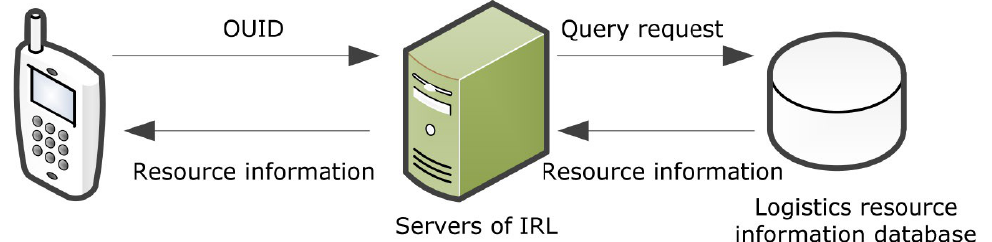
Figure 7. Process of Two Dimensional Bar-code Information Query Using Mobile